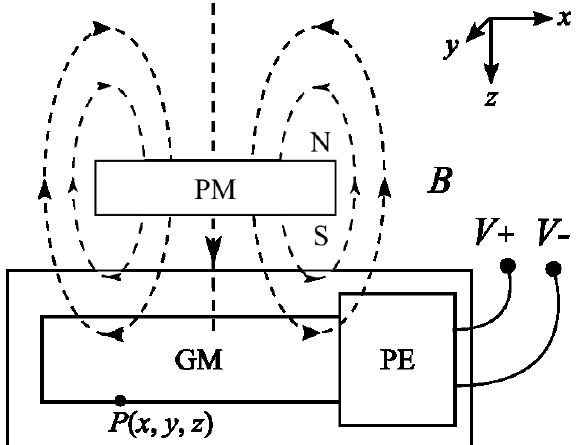
Figure 2. The schematic diagram of the sensing